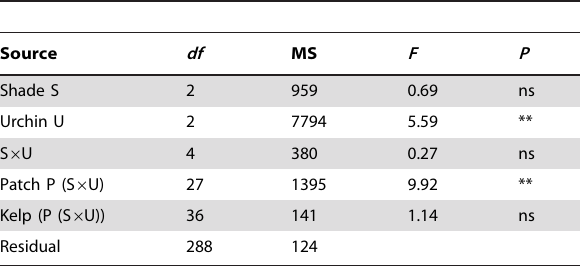
Table 1. Analysis of mean percentage covers of bryozoans on E. radiata for each individual 1 month after the shade and urchin exclusion experiment in 2009.